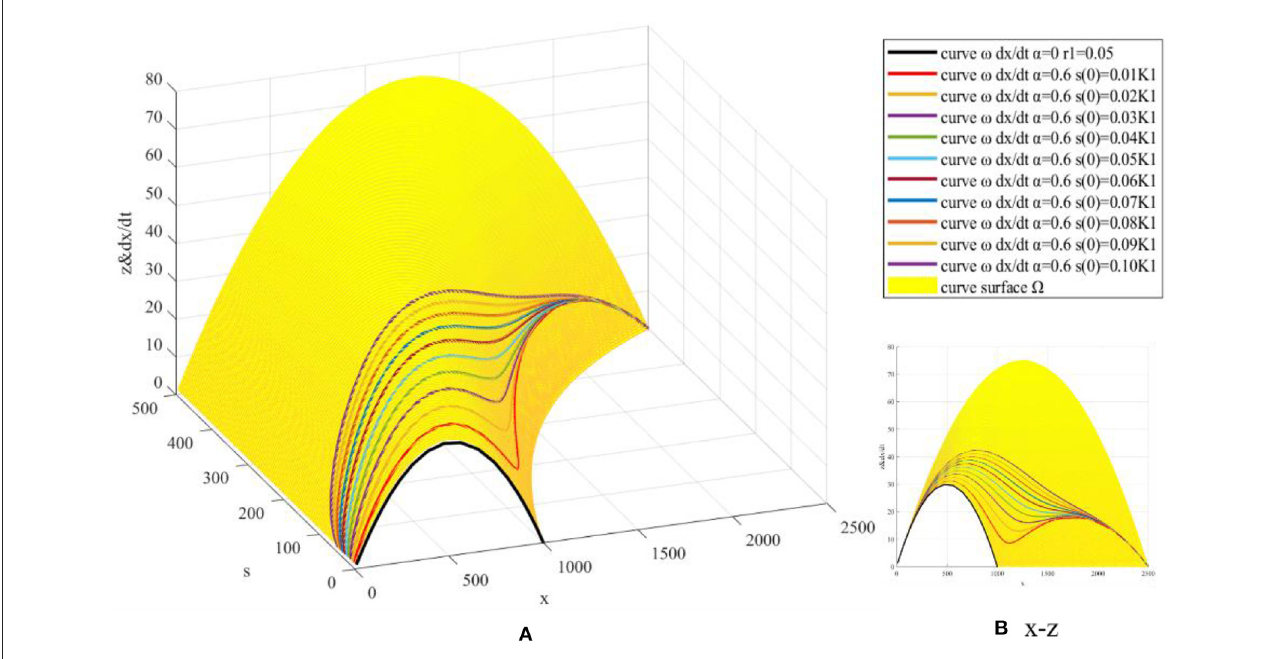
FIGURE7 Simulation based on s ( 0 ) .